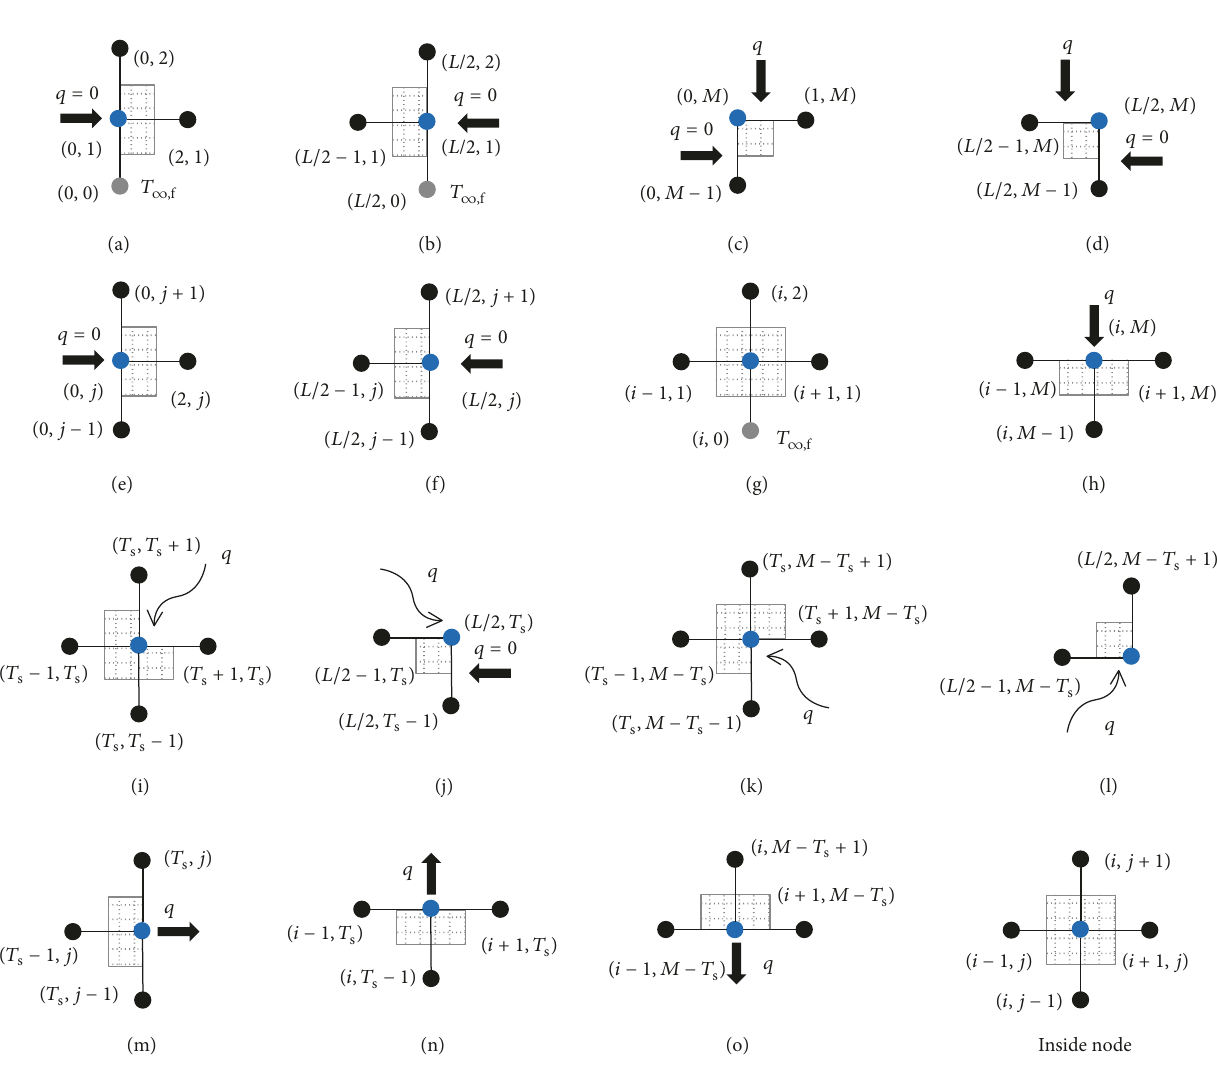
Figure 2: Schematic diagram of thermal boundary